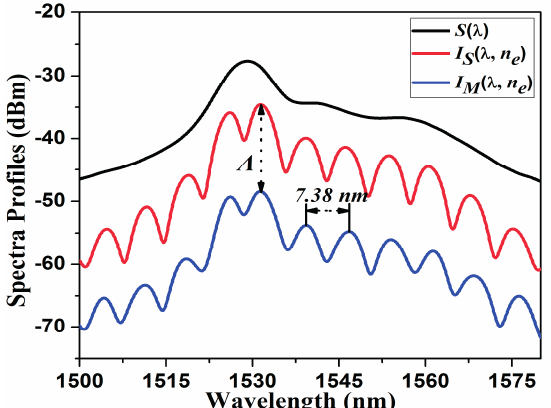
( ) ( ) ( ) λ S ; λ , I n and λ , I n are the measured M e S e n = was considered. e n . In Figure 6b a detail of the spectral profile is e